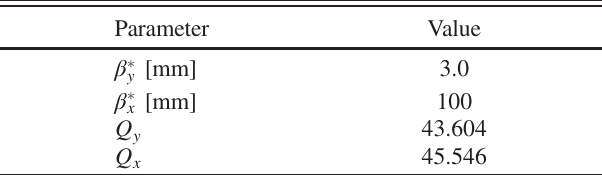
TABLE IV. Working point and β (cid:1) during measurements in HER. The measurements were done on 5th of June 2018, during phase 2 of SuperKEKB commissioning.